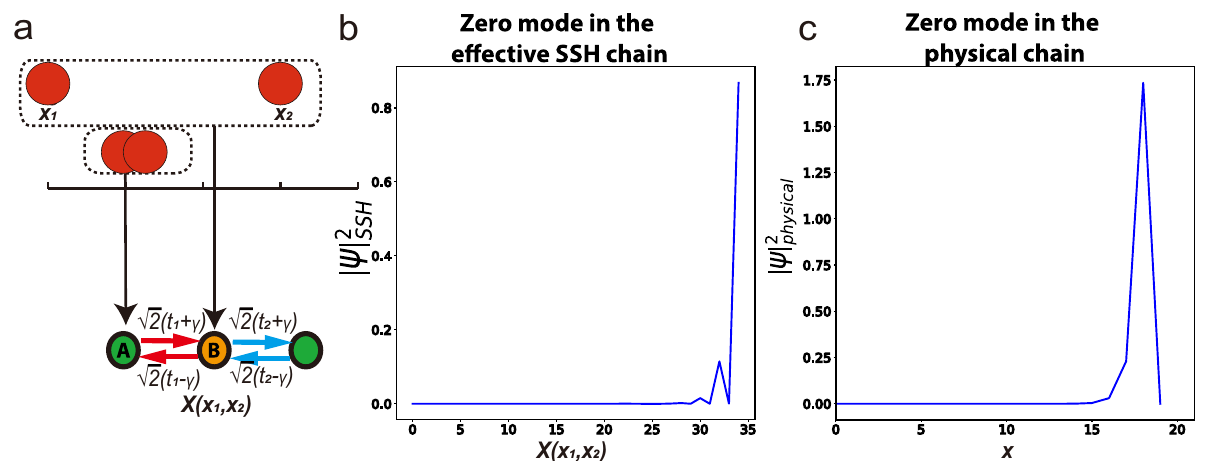
Fig. 6 Correspondence of skin modes from Eq. (4) in the real space and the effective chain. Correspondence of localizations in the real space and the effective chain for the two-boson sector under open boundary conditions (OBCs). a The Non-Hermitian effective SSH model corresponding to the physical two-boson model, and the corresponding two-boson state from the physical chain that maps to odd/even sites in the effective SSH chain. The squared amplitudes of the same zero mode in the effective chain b vs. the physical chain c with t 1 = 1.2, t 2 = 0.2, γ = 1.0, L = 20. The corresponding length of the effective SSH chain is 2 L − 5. X ( 1 , x 2 ) in b is given in Eq. (2), and x in c represents the position in the physical space.